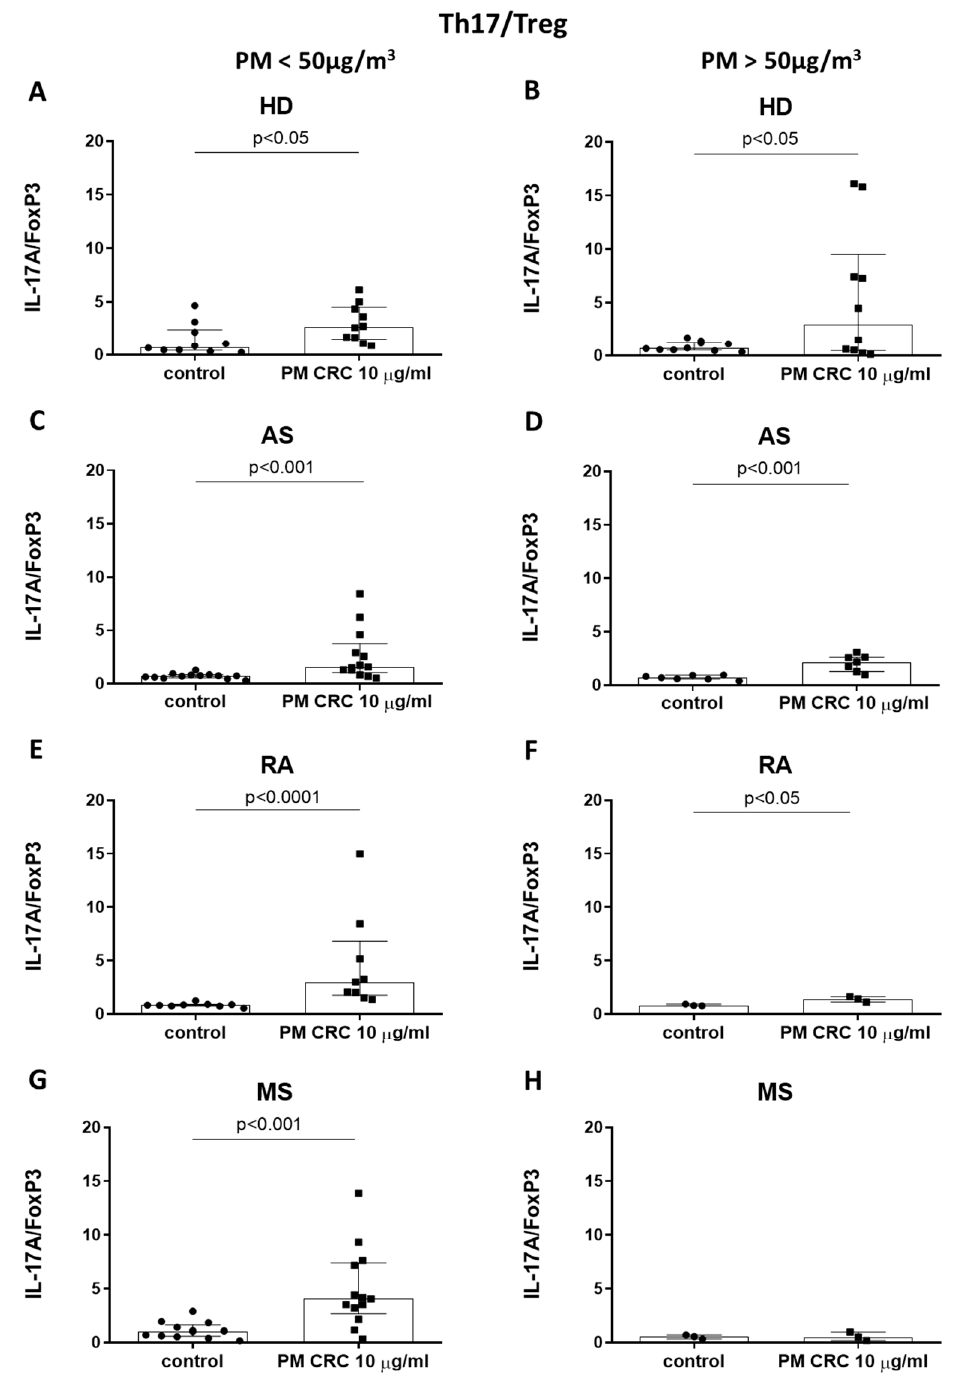
Figure 4. Effect of the exposure of PBMCs to PM CRC on the ratio of Th17/Treg cells in patients and HD with the seasonal changes in PM concentration in the air. After PBMCs stimulation, the frequency of CD4 + cells positive for IL-17A (Th17) and FoxP3 (Treg) and the corresponding Th17/Treg ratio were determined in HD ( A , B ) and patients with AS ( C , D ), RA ( E , F ), and MS ( G , H ). Results are presented concerning seasonal changes in PM10 concentration in the air, lower ( A , C , E , G ) or higher than the daily limit (50 μ g/m 3 ) ( B , D , F , H ). Data are presented as median ± interquartile range from 10 independent experiments for HD ( A , B ), 13 ( C ) and 7 ( D ) for AS, 8 ( E ) and 3 ( F ) for RA, 13 ( G ) and 3 ( H ) for MS. Statistically significant difference was estimated at p < 0.05. Moreover, in the season with high PM concentration (above a daily limit), stimula- tion of patients’ PBMCs with PM CRC was less effective than in the summer.